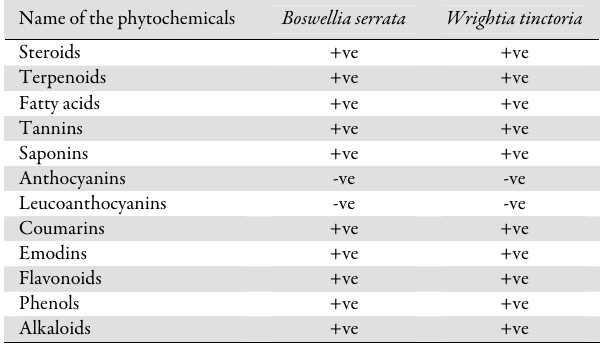
Tab. 1. Preliminary screening of secondary metabolites in Boswellia serrata and Wrightia tinctoria